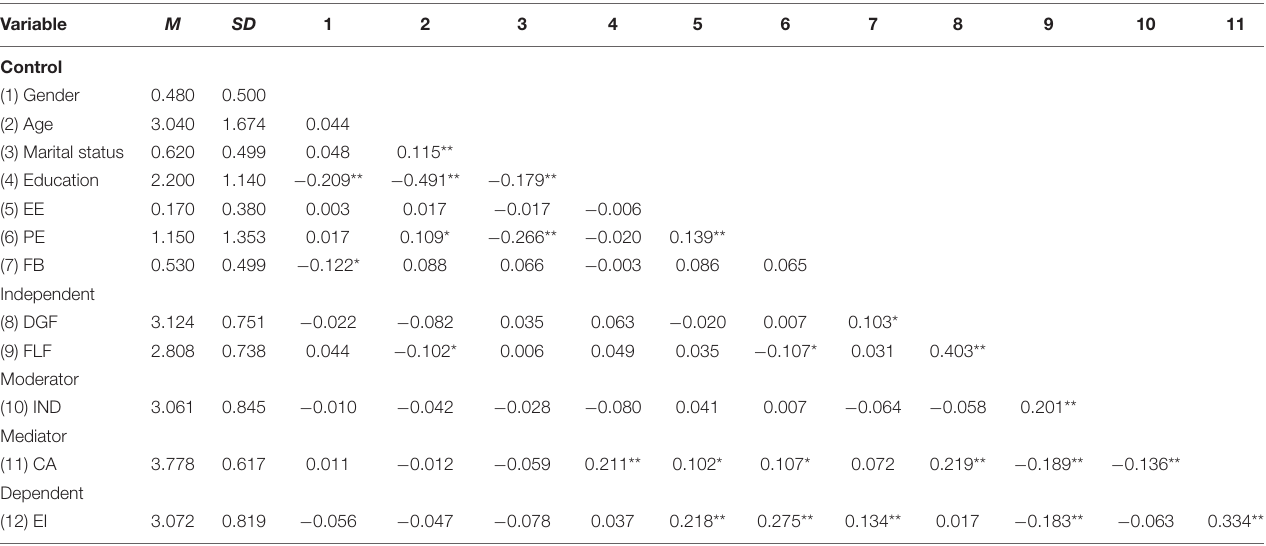
TABLE 1 | Means, standard deviations, and Pearson correlations among variables.